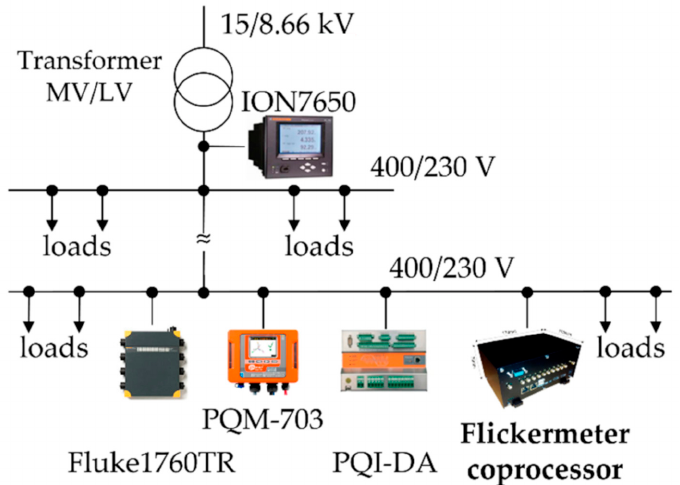
Figure 8. Simplified diagram of the test power system.